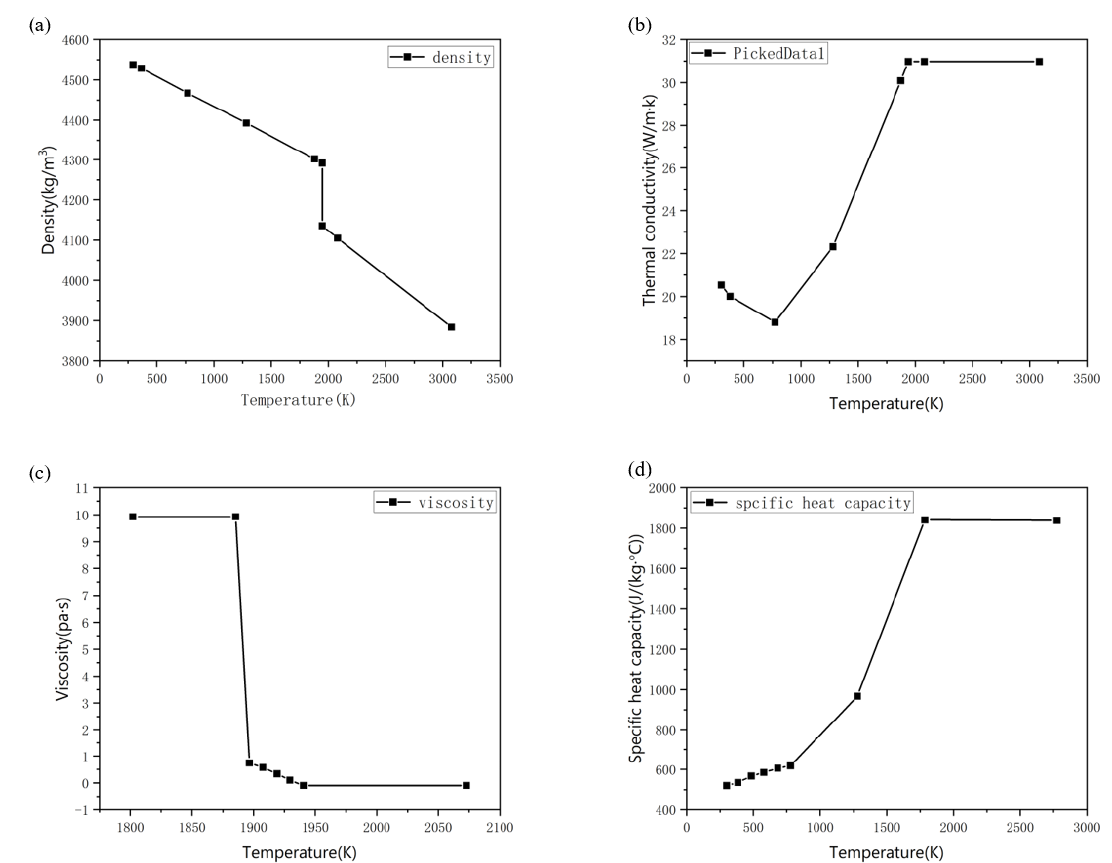
Figure 5. Thermophysical properties of Ti6Al4V and their temperature dependence ( a ). density; ( b ). thermal conductivity; ( c ). viscosity; ( d ). specific heat capacity. Table 1. Material parameters setting for simulation in fluid flow and heat transfer.